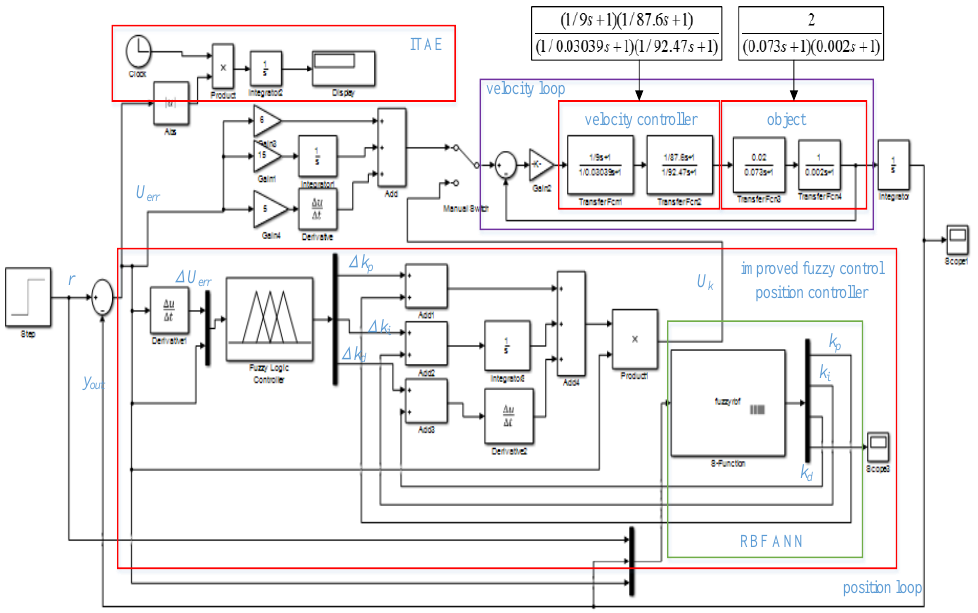
Figure 6. RBF ANN fuzzy PID control system.